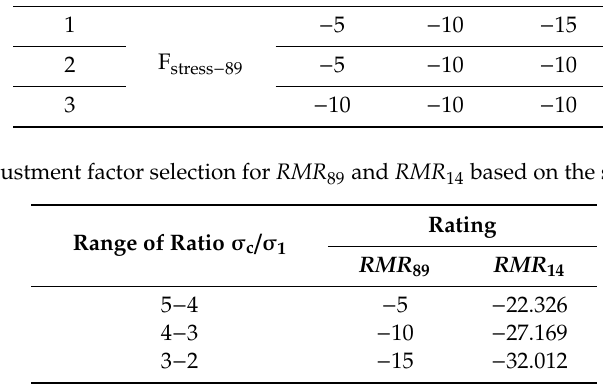
Table 3. Hypothesis used for the stress adjustment factor for RMR 89 . Hypothesis